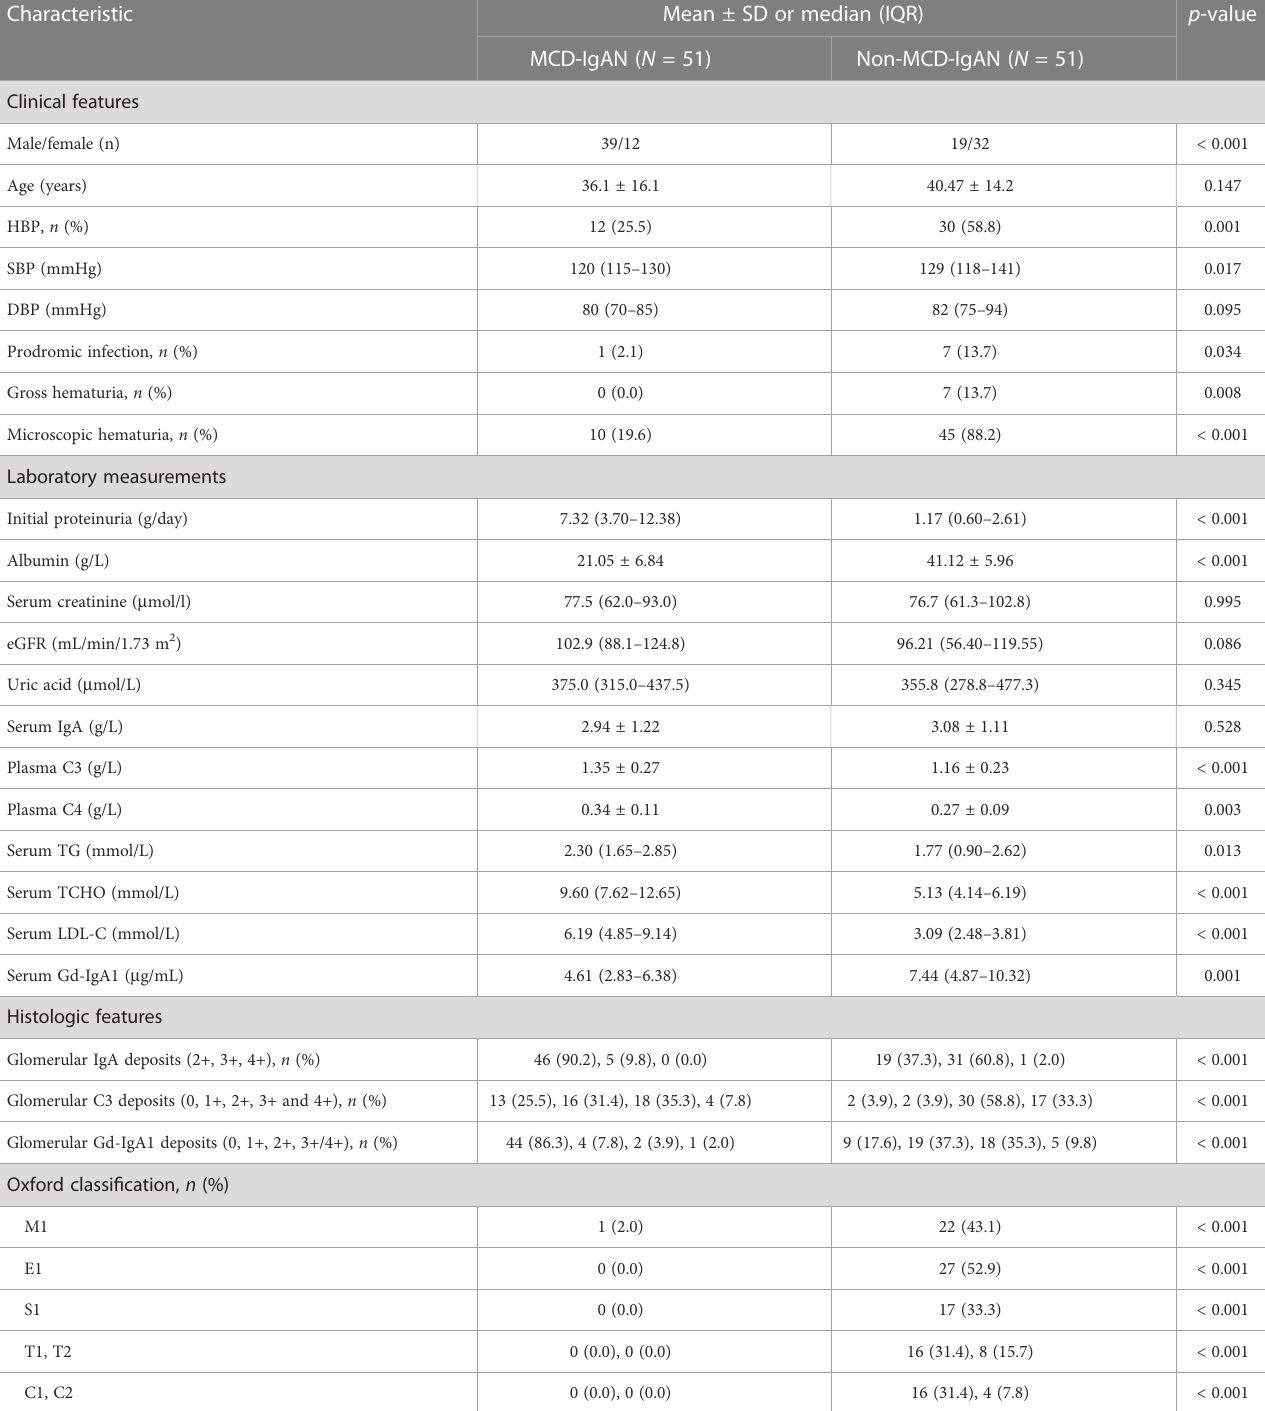
TABLE 1 Demographic, clinical, and histologic characteristics of patients with minimal change disease (MCD)-immunoglobulin A nephropathy (IgAN) and non-MCD-IgAN.